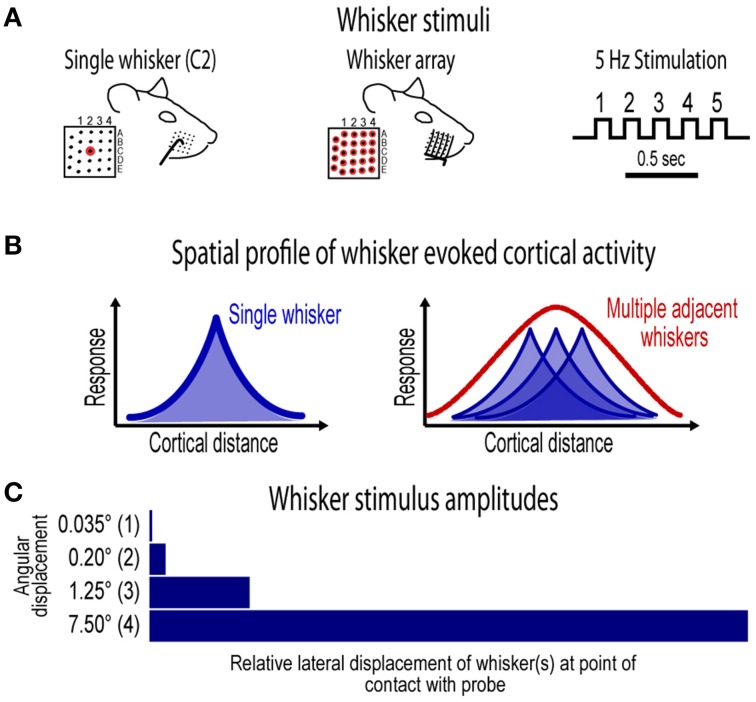
Whisker stimuli and spatial profile of whisker evoked ensemble activity in barrel cortex. (A) Ensemble-based invariance was investigated for two types of whisker stimuli- a single central whisker located at the center of the whisker pad (whisker “C2,” left) and the whisker array including all 24 large mistacial whiskers (middle). Whisker stimuli were delivered at a 5 Hz rate and consisted of 5 deflections per trial (right). (B) Schematics of previously reported spatial profiles of single whisker and whisker array evoked activity in barrel cortex (Chen-Bee et al., 2012). Note the large, overlapping profiles for single whisker and the single, central peak in the profile for whisker array. (C) Ensemble-based invariance was tested across logarithmic (base 6) changes in whisker stimulus amplitude that ranged from a barely visible movement of the whisker(s) at 0.035° to the relatively large stimulus amplitude of 7.5°.